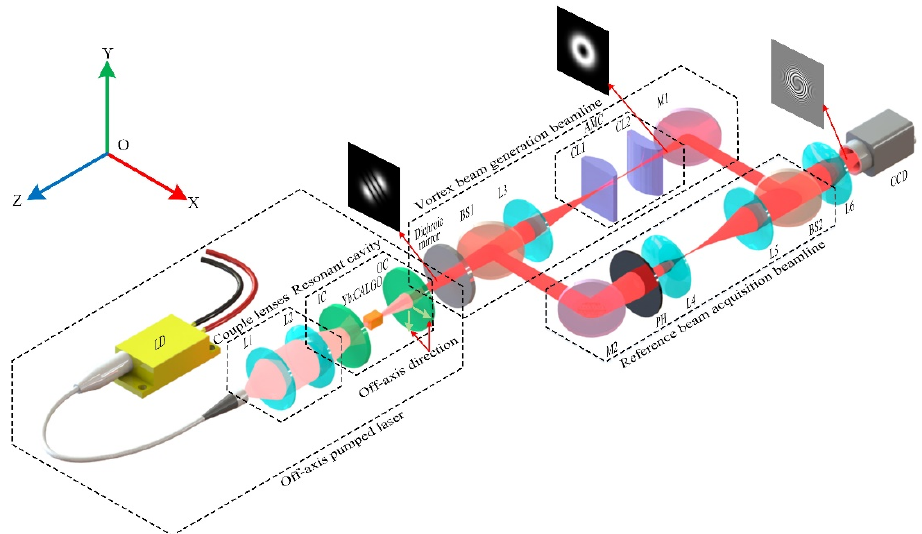
Figure 1. Configuration of the mode-tunable vortex laser. Table 1. Parameters of the mode-tunable vortex